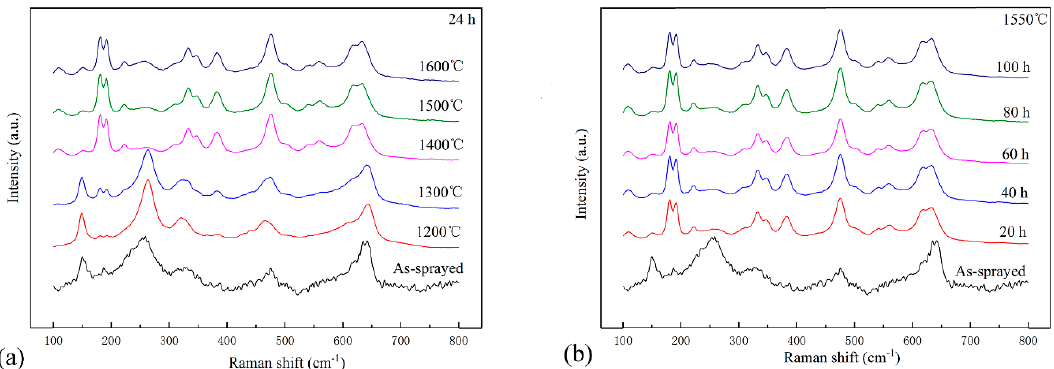
Figure 9. Raman spectra of the as-sprayed coating and heat-treated coatings: ( a ) samples after heat-treatment for 24 h at different temperatures; ( b ) samples after heat-treatment at 1550 °C for different times.